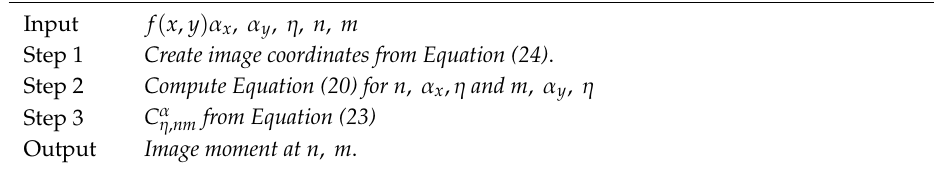
Algorithm 2: Generalized Fractional order Orthogonal Chebyshev Moments (GFCMs)